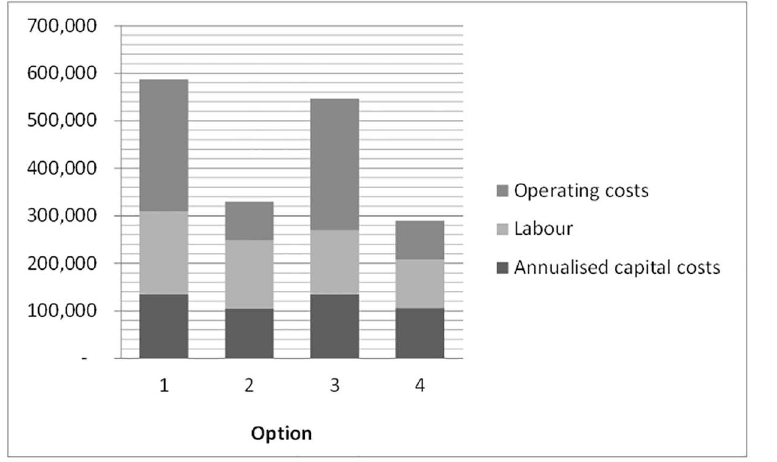
Fig 1. Breakdown of annualized costs for each option (in